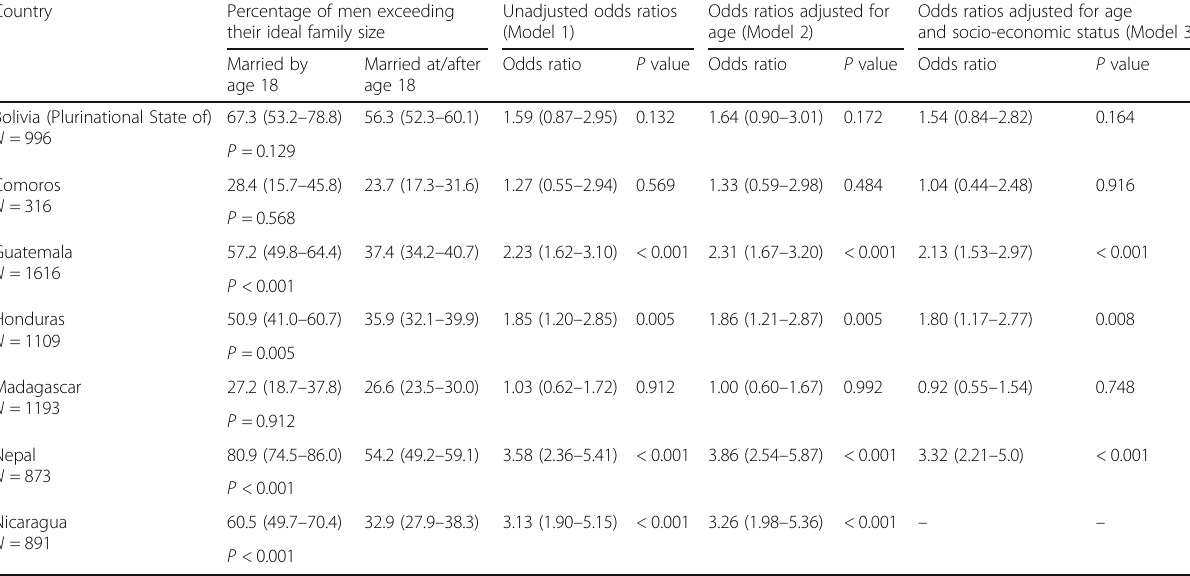
Table 12 Odds of having exceeded one ’ s ideal family size at the time of survey based on the total number of children ever fathered, comparing men currently aged 40 – 49 who were married by age 18 with those married at or after 18 (reference